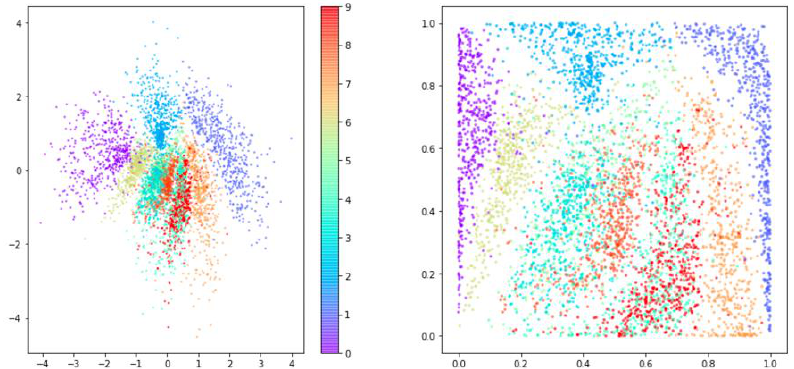
Figure 3. Representation of a VAE latent space for the MNIST dataset (left side) and its cumulative normal distribution (right side).